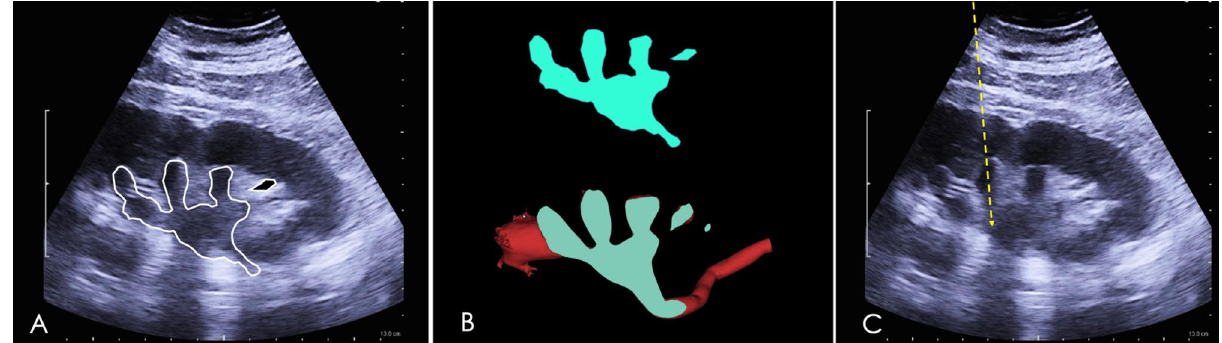
Figure 7. Accurate navigation of the puncture through the axis of the targeted renal calyx. ( A ) Ultrasonographic (US) observation of the section profile (white contour) of the renal collecting system. ( B ) US profile of the renal collecting system (superior blue contour) was highly consistent with the optimal axial section C (inferior blue contour). ( C ) Direction of the ultrasonic probe was now fixed, and the puncture route (yellow arrow) through the center of the targeted renal calyx section was the axis of the targeted renal calyx.